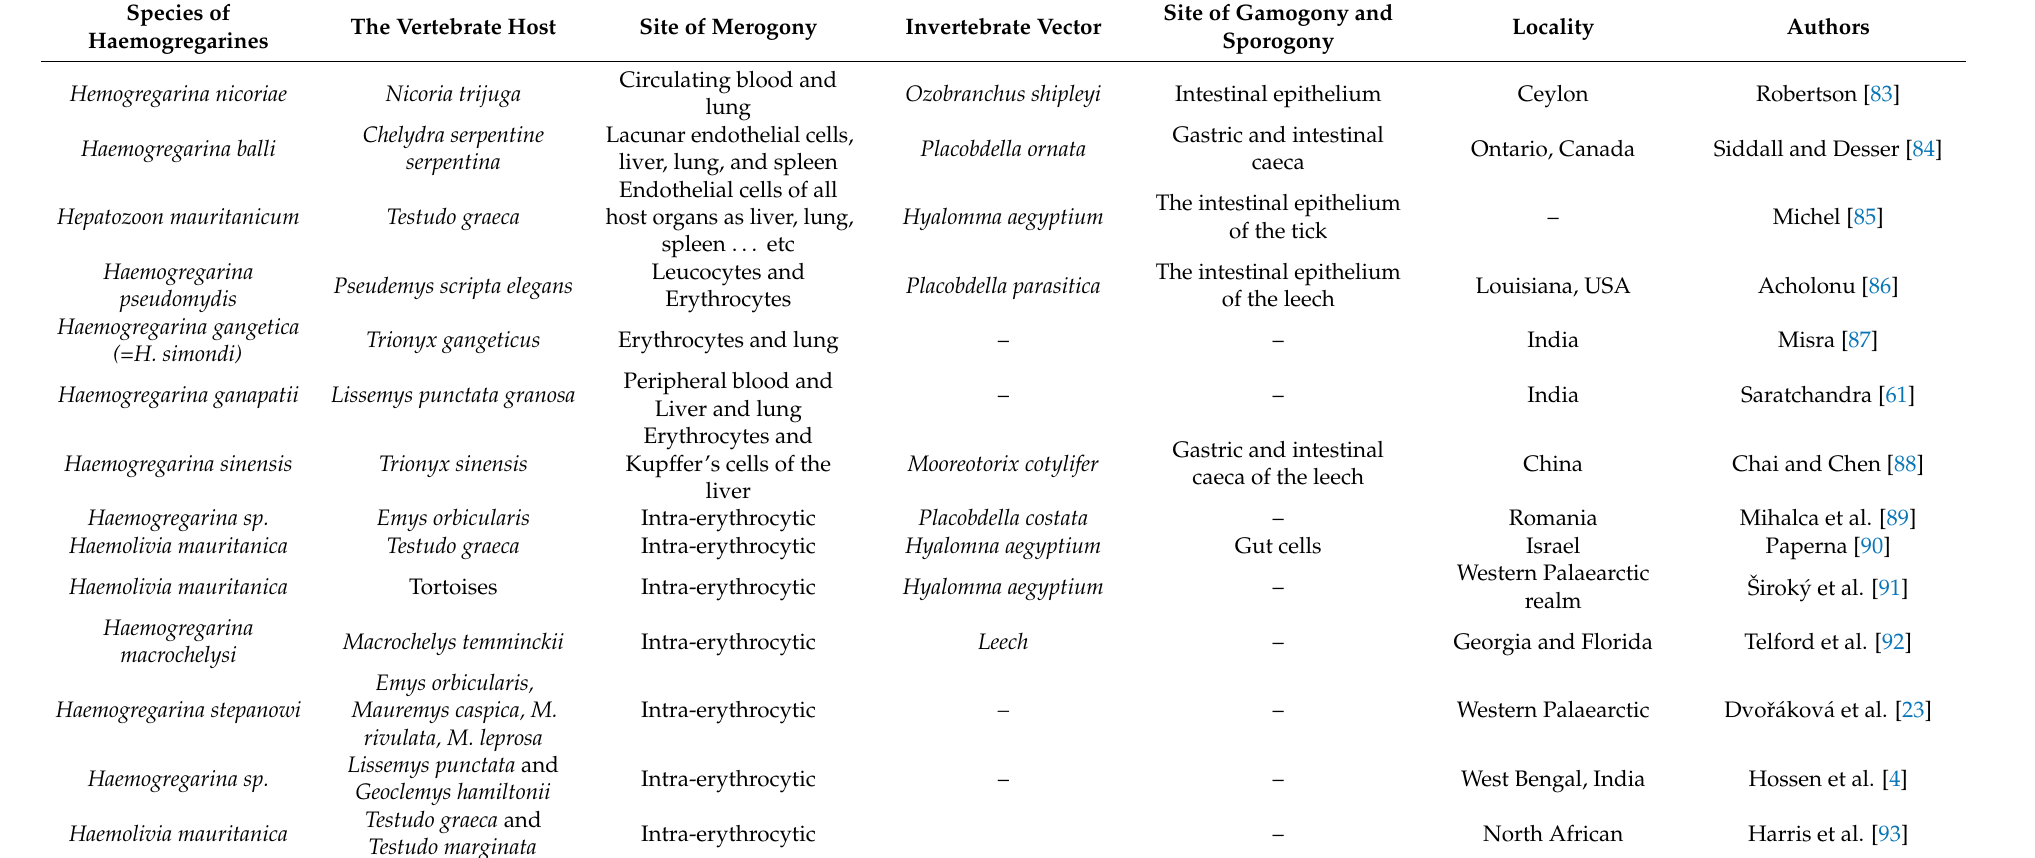
Table 6. Haemogregarines of turtles and